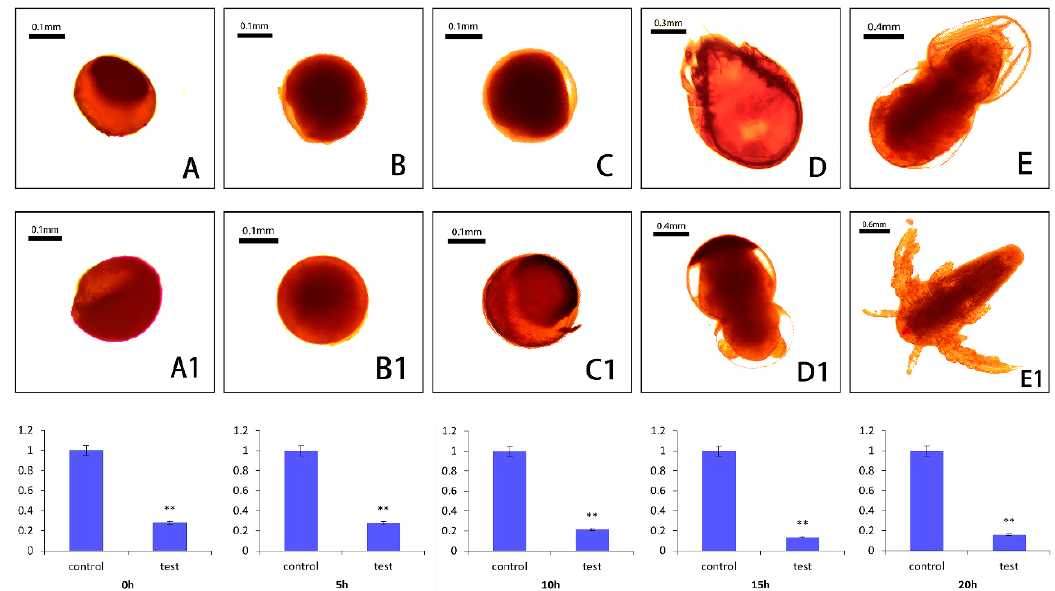
Figure 9. Relative expressions of As– RAD9 at different stages after adding the RNAi probe. A–E represents the experimental group; A1–E1 represents the control group. The qPCR analyses of As– RAD9 expression levels were shown below. Data are mean ± SD of three replicate experiments, * indicates a significant difference from the control ( P < 0.05), and ** indicates a very significant difference compared to the control ( P < 0.01).